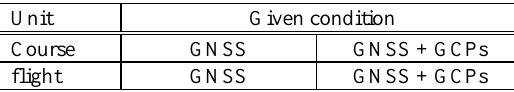
Table 4. Processing combination